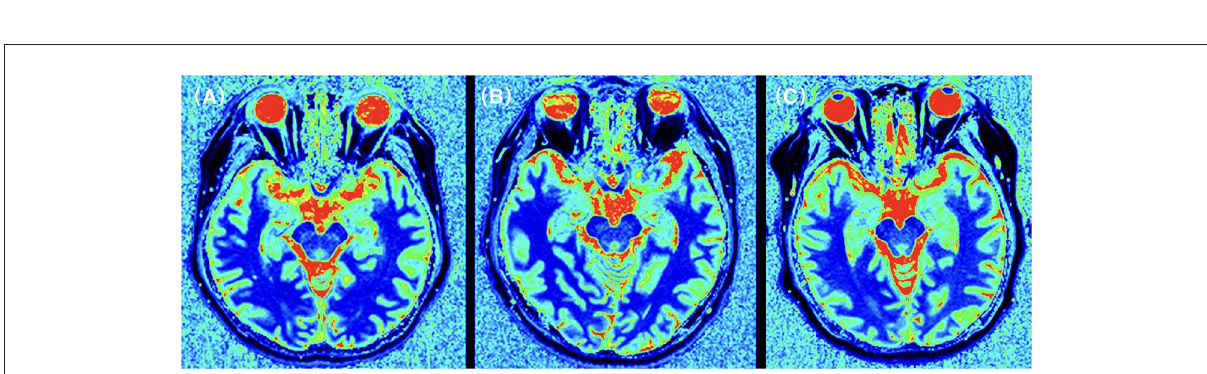
FIGURE2 T1 relaxation times for the temporal lobe in an CI patient (A) , a N-CI patient (B) , and a healthy control (C) . T1 relaxation maps was generated for each subject. ROIs were manually plotted on these maps and parameter values were recorded. The results showed that the T1 relaxation times in the frontal lobe of the CI group were higher than those in the N-CI and normal groups ( p <